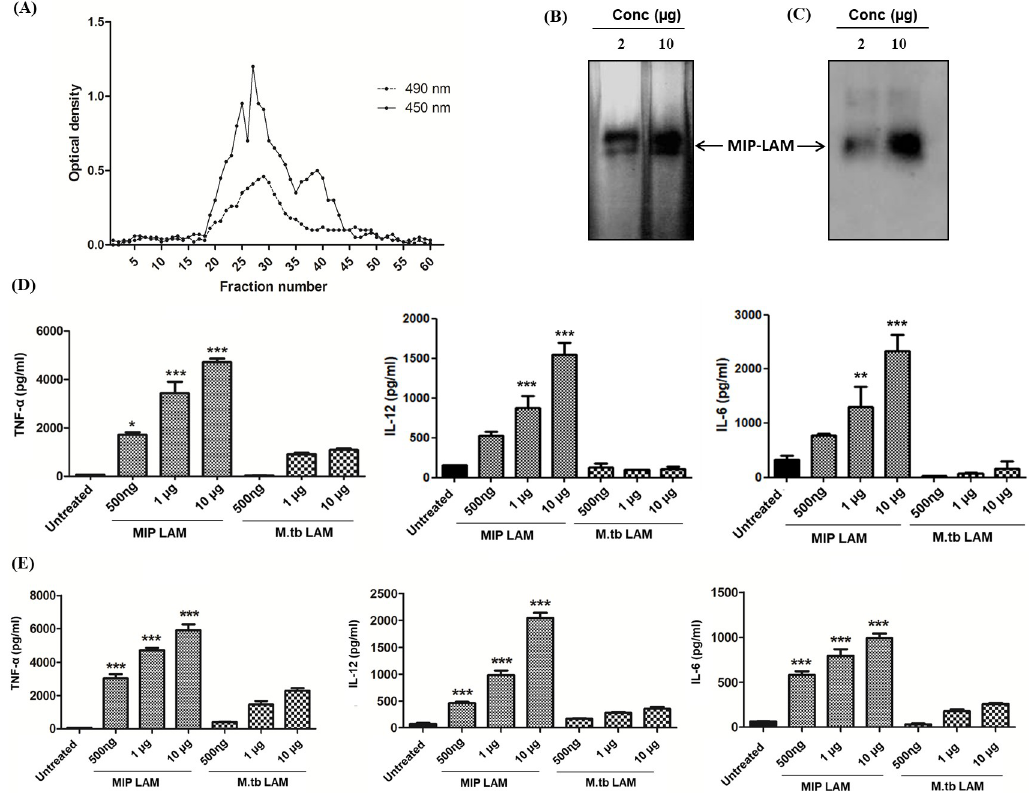
Fig 2. Isolation and purification of LAM. Crude LAM (10 mg/ml PBS) was passed through sephacryl S-100 column (equilibrated with PBS) at flow rate of 0.5 ml/min. Fractions of 3 ml each were collected. Carbohydrate content (dotted line, O.D. at 490 nm) and LAM content (Solid line, O.D. at 450 nm) in each fraction was determined by phenol-sulphuric acid method and by ELISA (A) Fractions 19 to 34 were pooled, concentrated and presence of LAM was confirmed by silver staining (B) and Western blotting (C). Analysis of immunostimulatory property of MIP-LAM. Macrophages / BMDCs were stimulated with varying concentrations of MIP-LAM / M . tb- LAM for 24 h. Level of TNF- α , IL-6 and IL-12 in the culture supernatant of macrophages (D) or BMDCs (E) was determined by ELISA. Data represents the mean with SEM of three independent experiments. [ � : p � 0.05; �� : p � 0.01; ��� : p � 0.001; comparisons were made between cytokines induced by same concentration of MIP-LAM and M . tb-